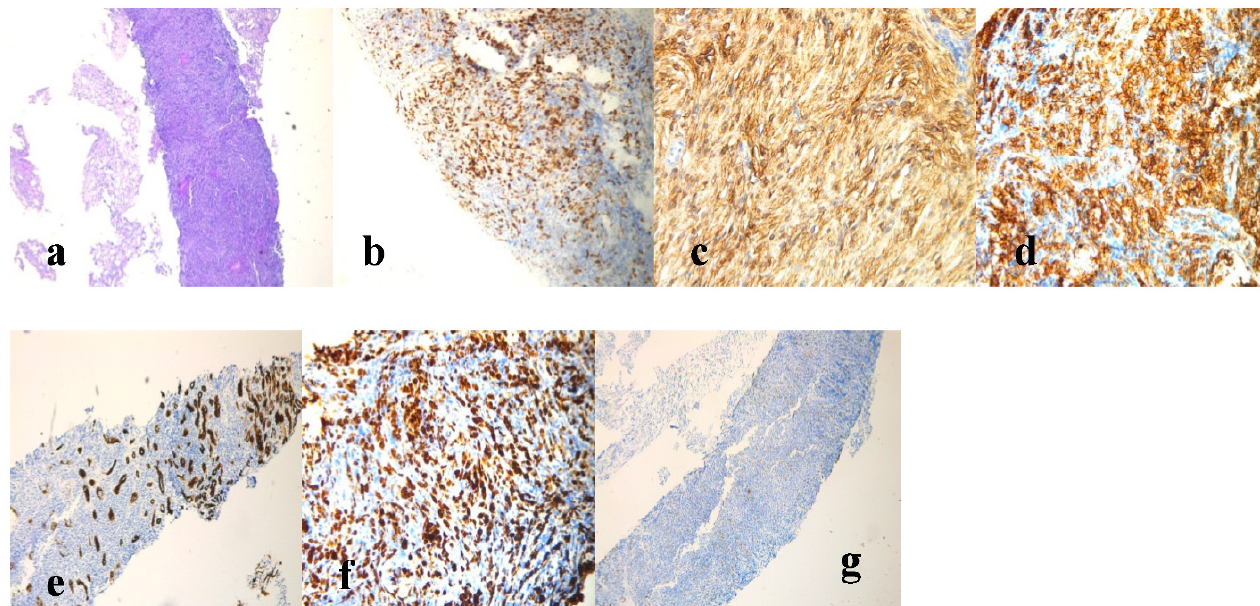
Figure 3. Histological examination of the renal specimen and immunohistochemistry staining were consistent with the diagnosis of DLBCL.( a ) Hematoxylin and eosin (HE)staining; ( b ) BCL6 staining. ( c ) CD10 staining (20 × magnification); ( d ) CD20 staining (20 × magnification); ( e ) CKMNF116 staining; ( f ) Ki-67 staining (20 × magnification); ( g ) CD3 staining (4 × magnification).